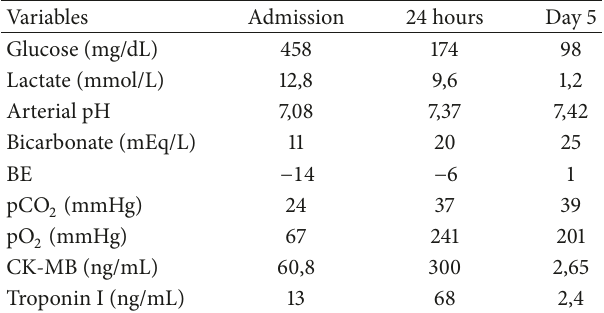
Table 1: Laboratory findings on admission and during